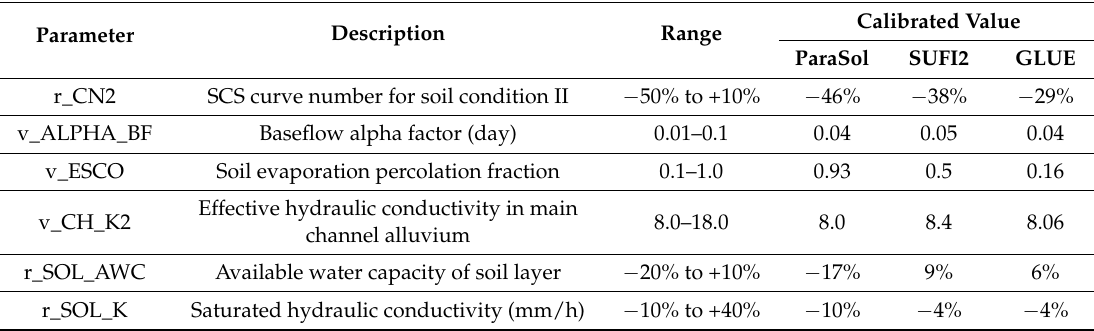
Table 1. Calibrated parameter values for monthly streamflow in the Jingchuan River Basin using Parasol, SUFI2, and